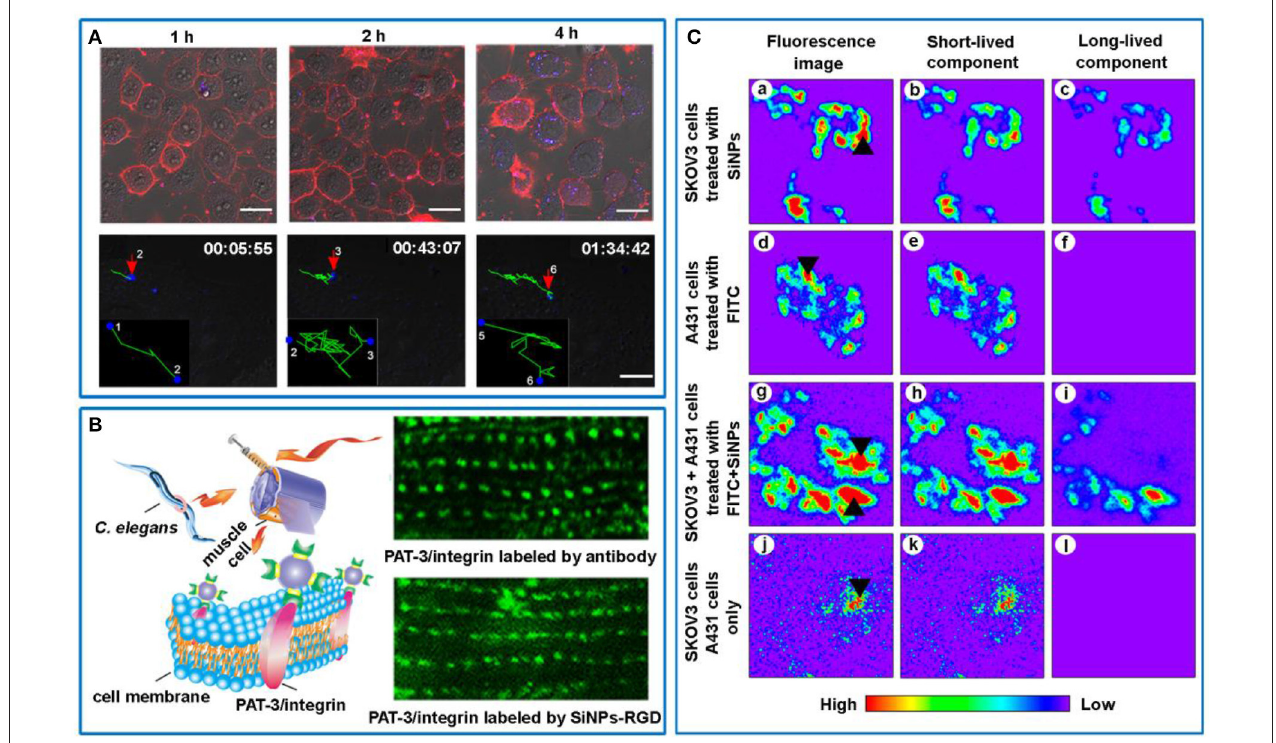
FIGURE 2 | (A) Confocal images of time-dependent cellular uptake of PEI-SiNPs/pDNA nanocomplexes in HeLa cells (top panel). Cell membranes were stained with Dil. Fluorescence of SiNPs and Dil is defined as blue and red, respectively. Scale bars = 20 µ m. Bottom panel: Real-time and long-term tracking the dynamic movement of the nanocomplexes in a live cell. The movement trajectory is delineated in green line. Reprinted with permission from Pang et al. (2016). Copyright (2016) Springer. (B) Schematic illustration of SiNP-RGD for labeling PAT-3/integrin at the muscle cell membrane in C. elegans (left panel). Right panel: Specific labeling the subcellular PAT-3/integrin using SiNP-RGD and PAT-3 antibody. Reprinted with permission from Zhou et al. (2017). Copyright (2017) Springer. (C) Fluorescence images and time-gated confocal images of SKOV3 cells immunostained by anti-HER2-modified SiNPs (a–c) , A431 cells stained by anti-mouse secondary antibodies-labeled FITC (d–f) , co-cultured SKOV3 cells and A431 cells labeled by anti-HER2-modified SiNPs and FITC coupled with anti-mouse secondary antibodies, respectively (g–i) , and non-treated SKOV3 cells and A431 cells (j–l) . Reprinted with permission from Tu et al. (2017). Copyright (2017) ACS Publications.